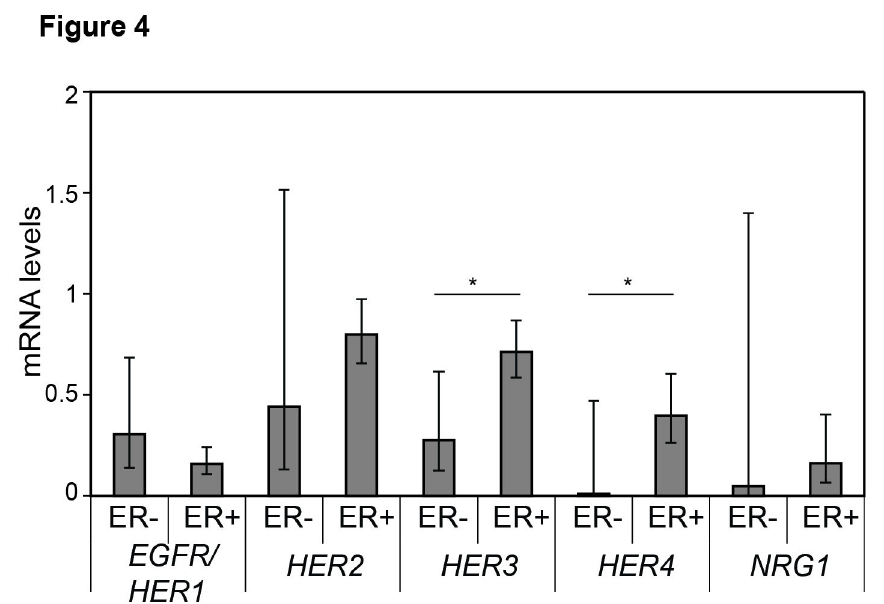
Figure 4. HER1-4 and NRG1 intratumoural levels related to estrogen receptor status among postmenopausal women. Geometric mean with 95% confidence intervals of EGFR/HER1 , HER2 , HER3 and HER4 levels in estrogen receptor positive (ER+) and ER negative (-) HER2 non-amplified tumours from postmenopausal women. Significant differences between ER+ and ER- tumours are presented using the Mann-Whitney U test. doi: